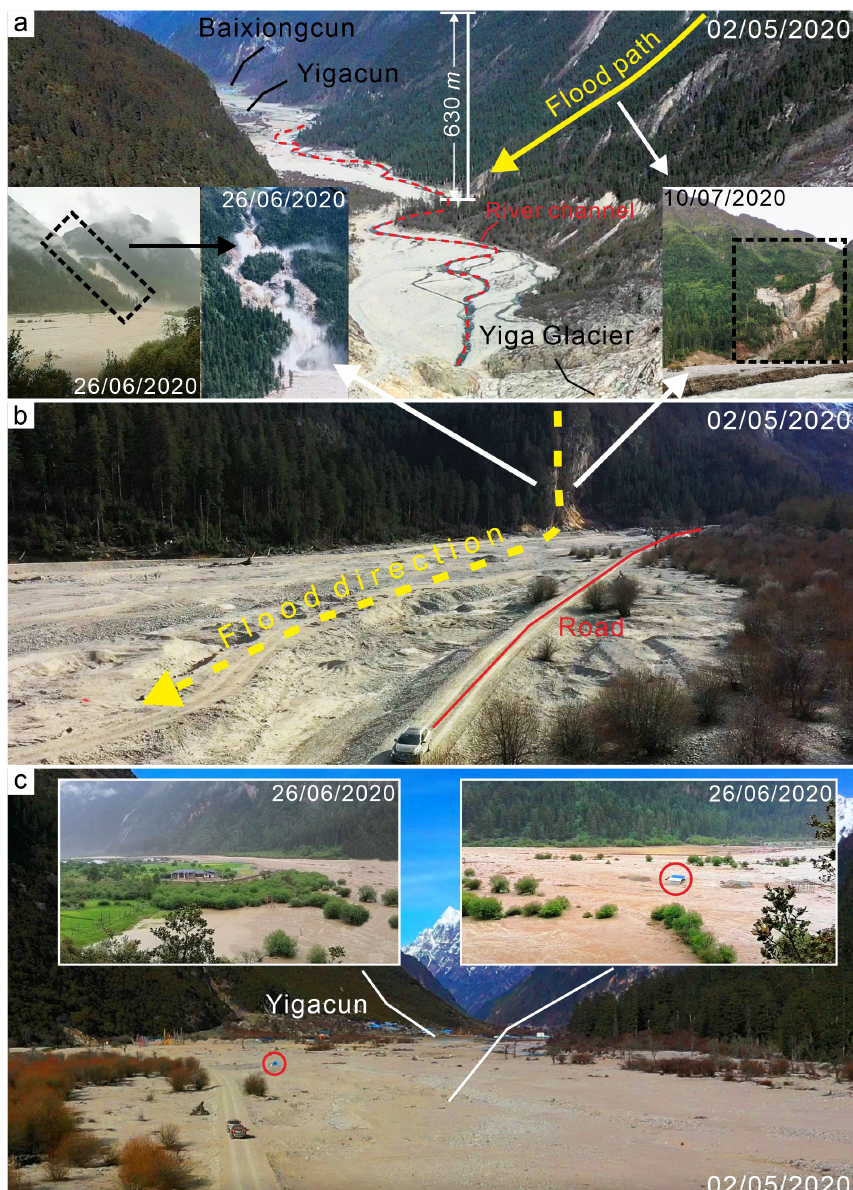
Figure 11. The situations in the valley and river channel below Jinwuco before, during, and after the GLOF. (a) Photo taken from Yiga Glacier looking to Yigacun. Insets showing the situations in the valley during and after the GLOF (photos: Qiangba Quying and Yixi Quzhen). (b) The river channel and road before the GLOF taken from Yigacun looking upstream. The yellow dashed line is the flood flow direction. (c) A view taken from upstream looking to Yigacun. Insets showing the situations in the river channel during the GLOF (photos: Qiangba Quying). Aerial photos from 2 May 2020 were taken by Kejun